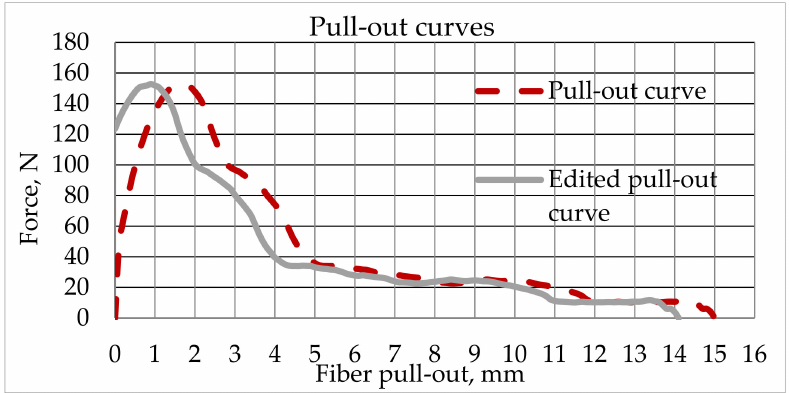
Figure 25. Real and edited pull-out